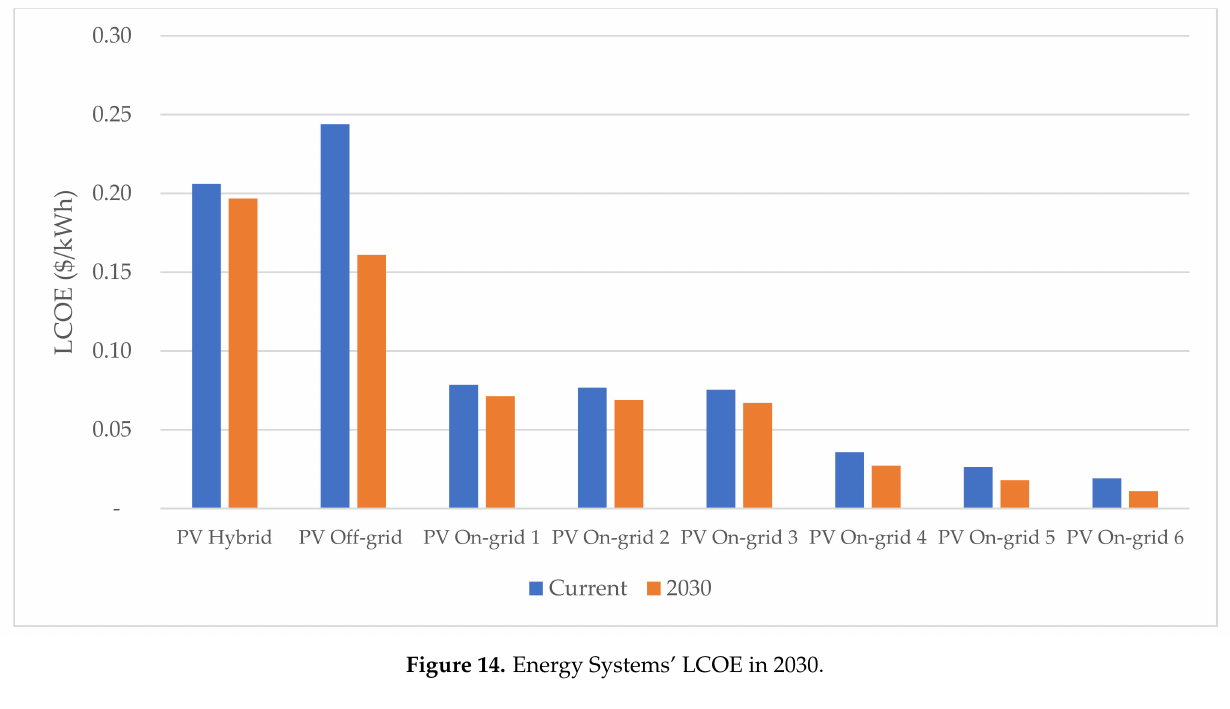
Figure 14. Energy Systems’ LCOE in 2030.